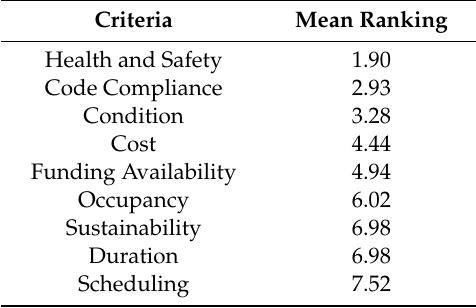
Table 3. The mean importance ranking of building maintenance decision-making criteria.